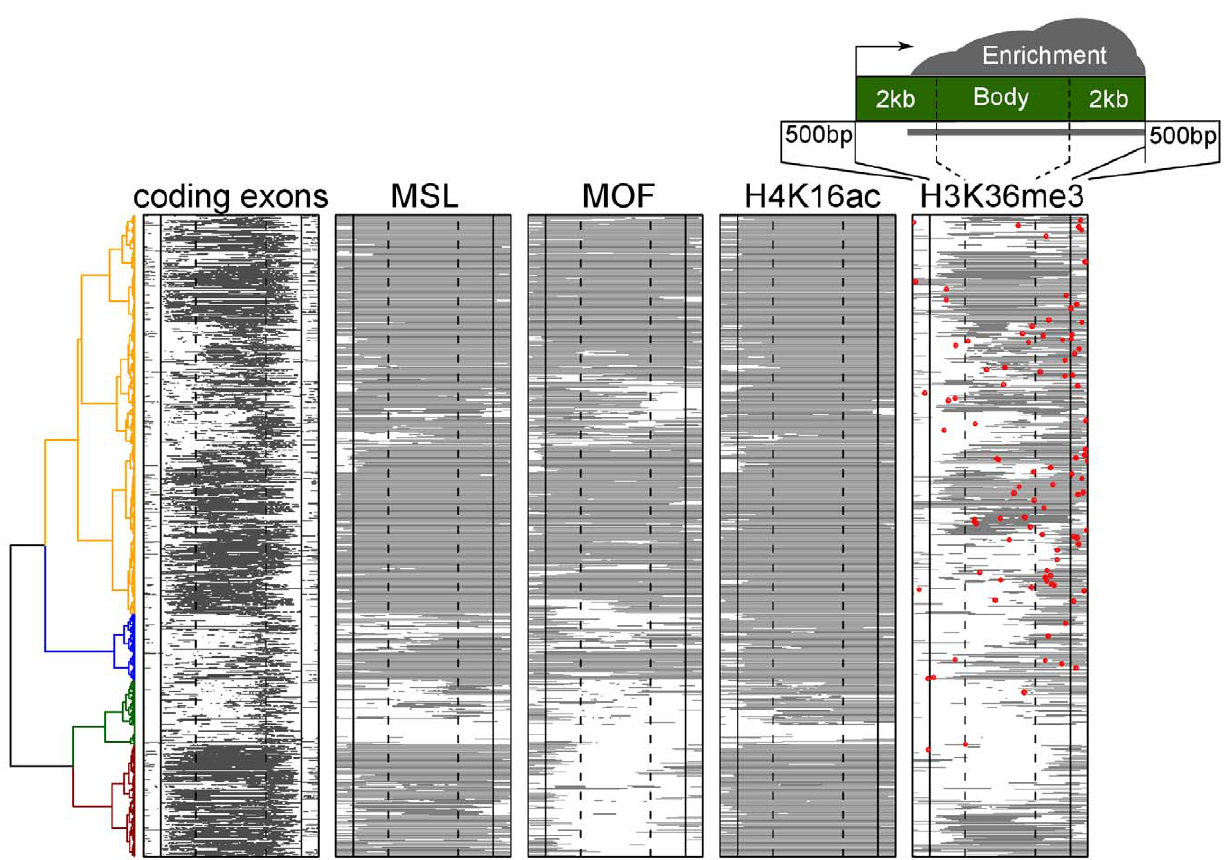
Figure 6. MSL1 and H4K16 acetylation are found on virtually all active X linked genes in male S2 cells. The plot shows the positions of exons, and the regions of enrichment for MSL1, MOF acetyltransferase, H4K16ac, and H3K36me3 along the bodies of active X linked genes. Each row represents an active gene scaled to the same size. The genes were clustered based on the chromatin features. These profiles show that CES (red dot on the H3K36me3 map) are located closer to the 3 9 end in general and are embedded within domains enriched for H3K36me3 as well as MSL1, MOF, and H4K16ac.